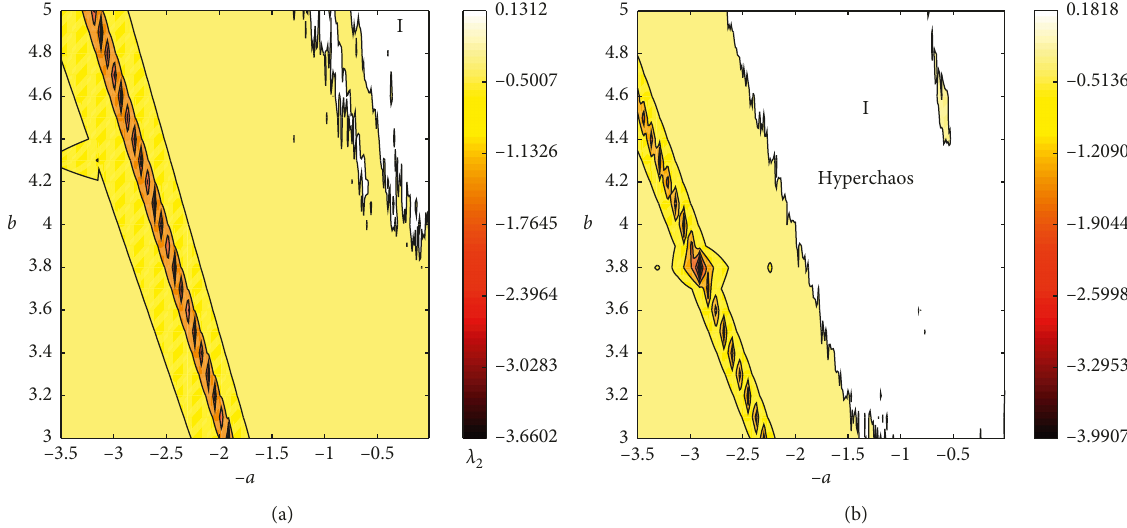
Figure 11: (a) The 2D LE diagram showing the second largest Lyapunov exponent ( λ 2D LE diagram showing the second largest Lyapunov exponent of the ACCM-Ikeda TD system in the ( a − b ) space.